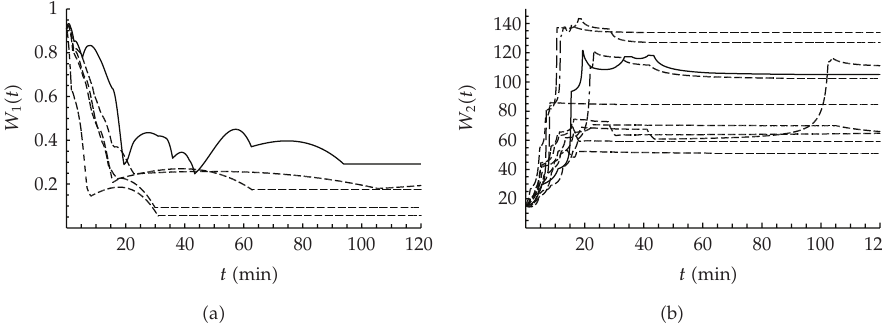
Figure 9: Evolution in (cid:5) 0; T (cid:6) of W 1 (cid:4) t (cid:7) (cid:4) a (cid:7) and W 2 (cid:4) t (cid:7) (cid:4) b (cid:7) evaluated for optimal distribution coe ffi cients (cid:4) continuous line (cid:7) and random choices (cid:4) dashed lines (cid:7) .